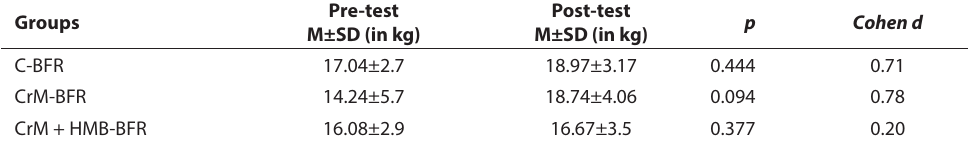
TABLE 1 Maximal Isometric Voluntary Contraction for C-BFR, CrM-BFR, and CrM + HMB-BFR Groups from Pre- to